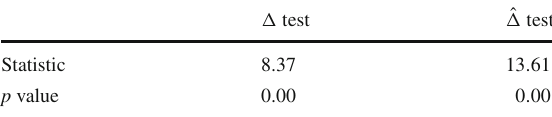
Table 1 Slope homogeneity tests in EBA